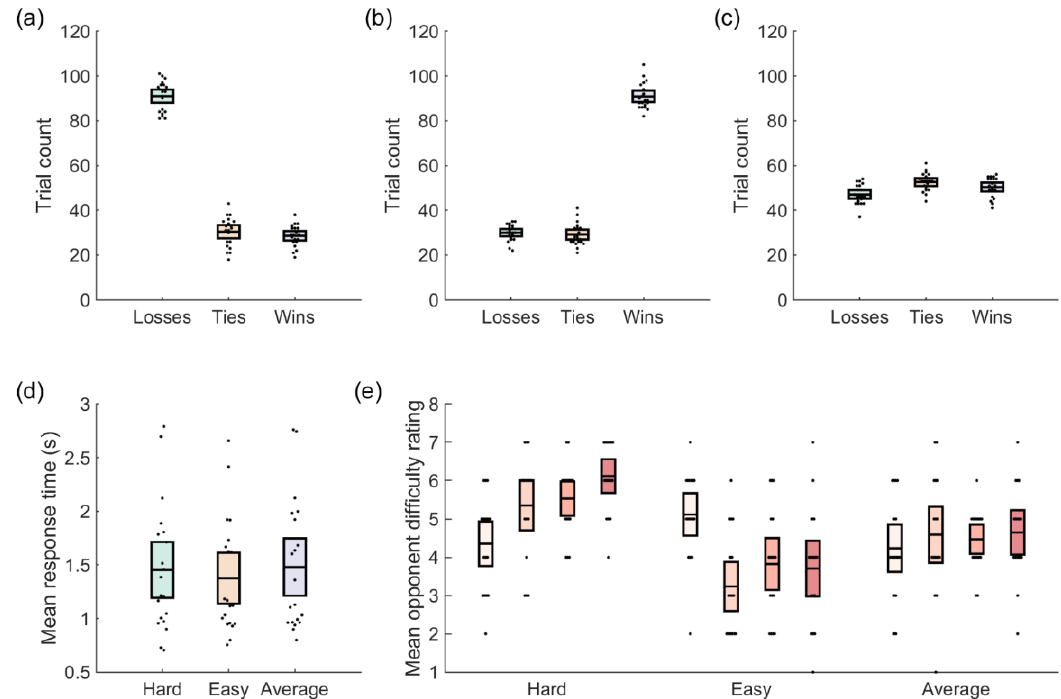
Figure 2. Behavioral data. Mean number of outcomes of each type for the ( a ) hard, ( b ) easy, and ( c ) average opponents. ( d ) Response times did not differ between opponent types. ( e ) Participant ratings of each opponent type at four different times during the experiment (pre-experiment, first rest break, second rest break, and post-experiment).